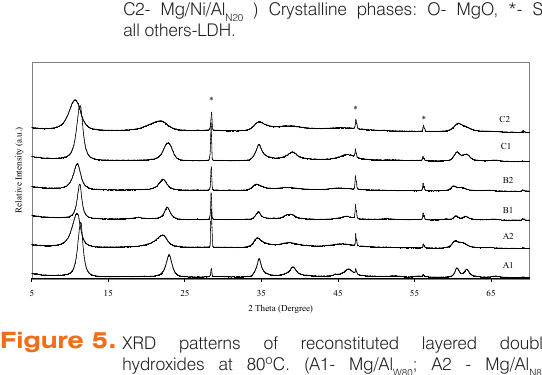
; A2 - Mg/Al W20 ; C1- Mg/Ni/Al N20